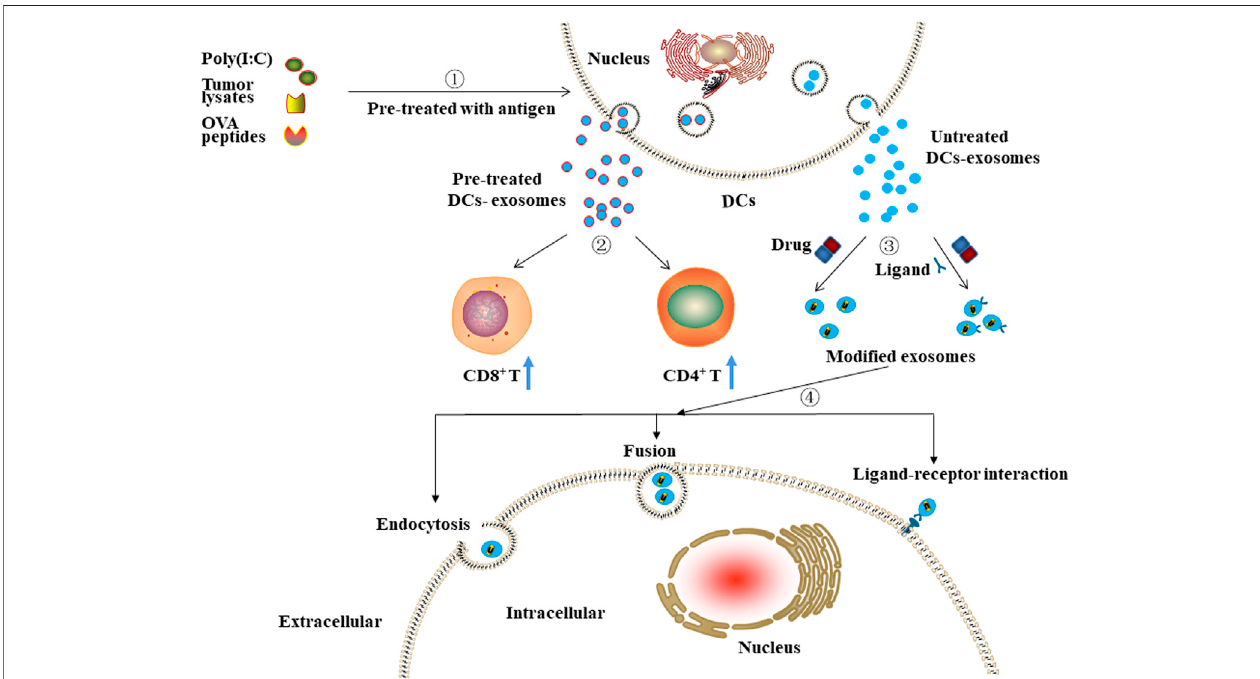
FIGURE 4 | The potential clinical application of DCs-derived exosomes. ① - ② Exosomes isolated from pre-treated DCs can stimulate the proliferation of immune cells,includingCD8 + andCD4 + Tcells. ③ - ④ ExosomesisolatedfromuntreatedDCsandthenmodi fi edwithtargetingmoietiesor/andloadedwithanti-cancerdrugscan exert anti-cancer effects through ligand-receptor interaction, fusion, or endocytosis.